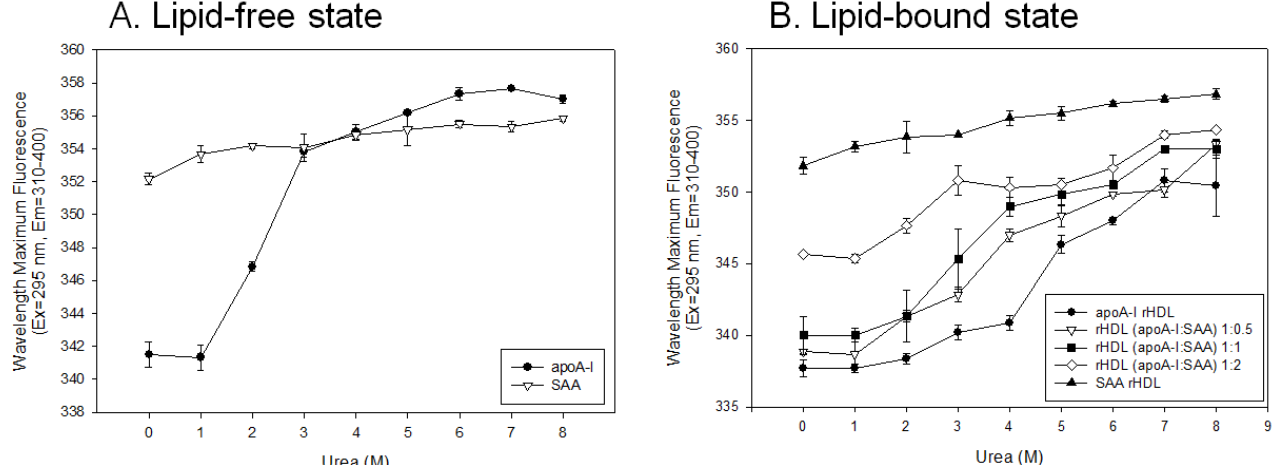
Figure 5. Isothermal denaturation of apoA-I and serum amyloid A (SAA) in the lipid-free state ( A ) and lipid-bound state ( B ) as reconstituted high-density lipoproteins (rHDL) with different molar ratios of apoA-I:SAA. With increasing urea treatment, change in Trp exposure was compared by fluorospectroscopy (Ex = 295 nm, Em = 310–400 nm) as wavelength maximum fluorescence (WMF).